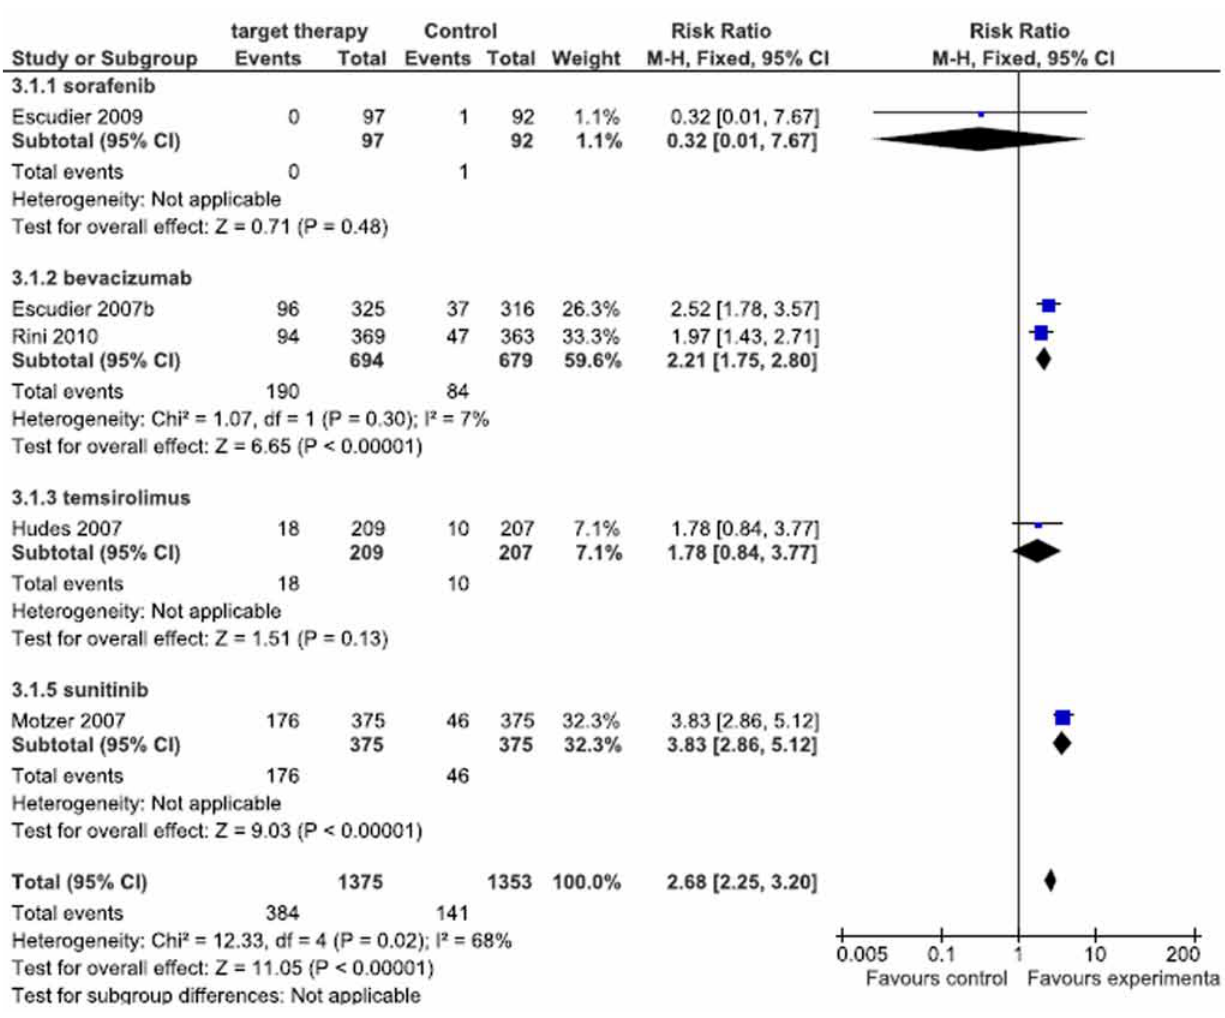
Figure 4 - Meta-analysis of Response